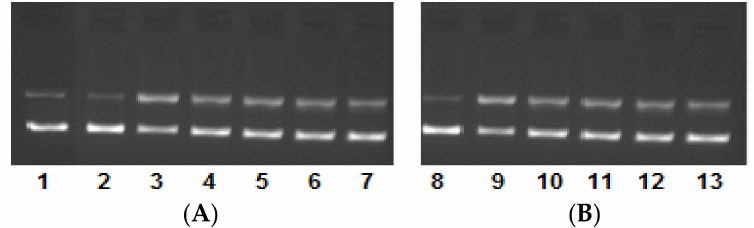
Figure 6. Mechanistic electrophoretic pattern of pBR322 DNA (100 ng) by ( A ) complex 1 and ( B ) complex 2 (0.5–2.5 µ M) in 50 mM of Tris-HCl/NaCl buffer pH 7.4 after 45 min of incubation